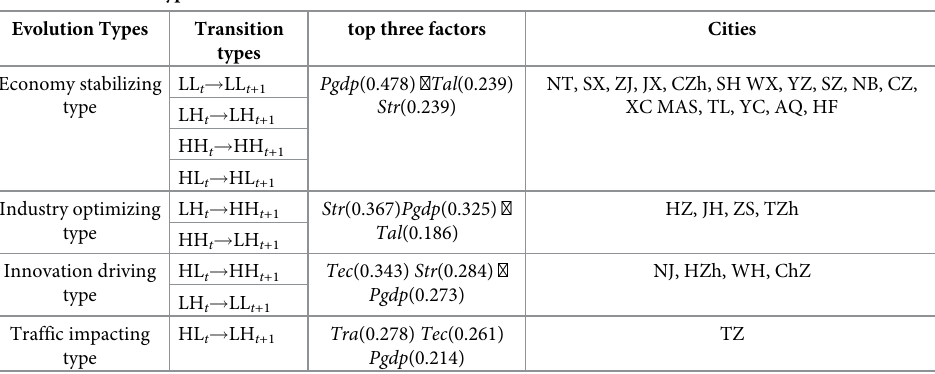
Table 8. Evolution types of